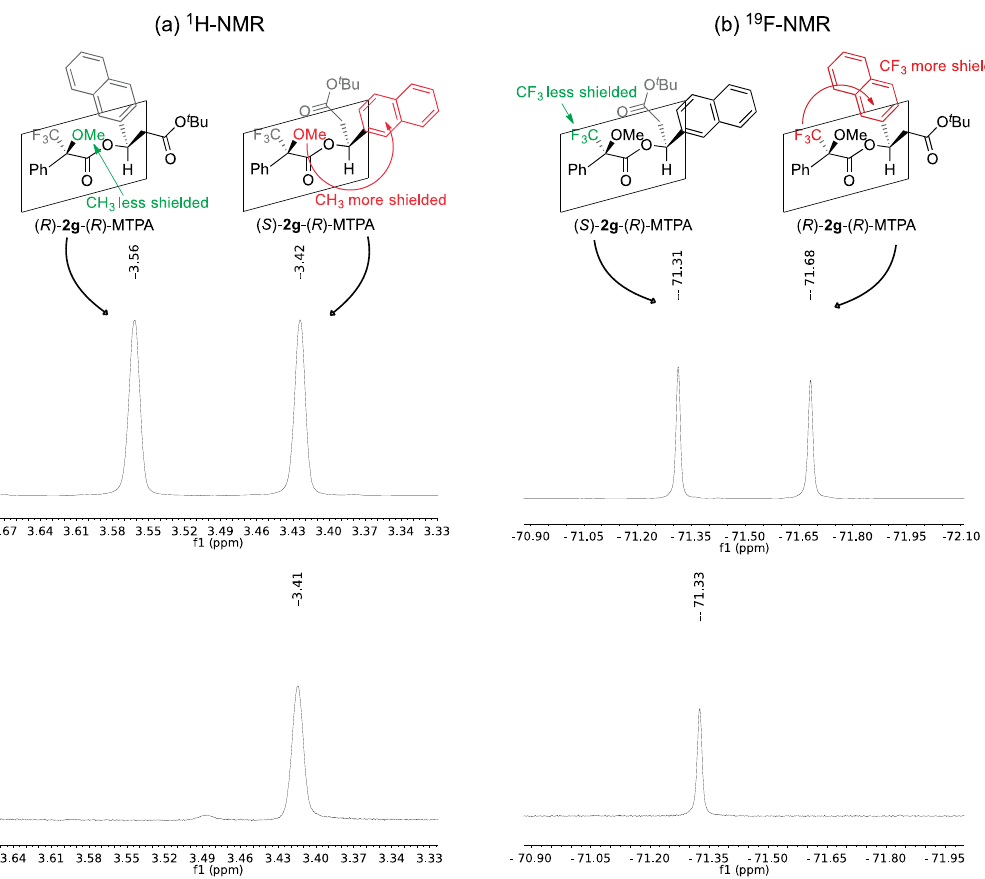
Figure 1. ( a ) 1 H-NMR of the methoxy region of ( R )-MTPA esters of rac - 2g (above) and ( R )-MTPA ester of ( S )- 2g (below); ( b ) 19 F-NMR of ( R )-MTPA esters of rac - 2g (above) and ( R )-MTPA ester of ( S )- 2g